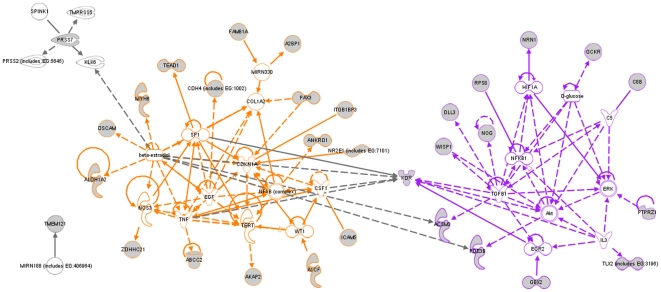
Network analysis of CTC-profile genes indicted two main functional networks: a cellular survival/proliferation associated network (colored orange) and a cellular migration/angiogenesis related network (colored purple).CTC-profile genes are indicated by grey symbols.